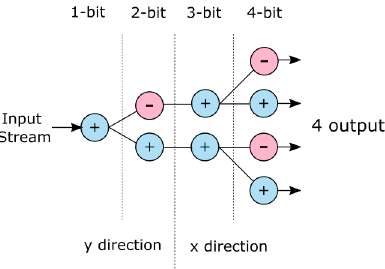
Figure 6. An example of how the operations in neural jet features can be arranged. The number of operations to calculate all features in a standard BNN convolutional layer scales with the number of output channels. For neural jet feature layers, the number of operations to calculate the features is the same regardless of how many output channels there